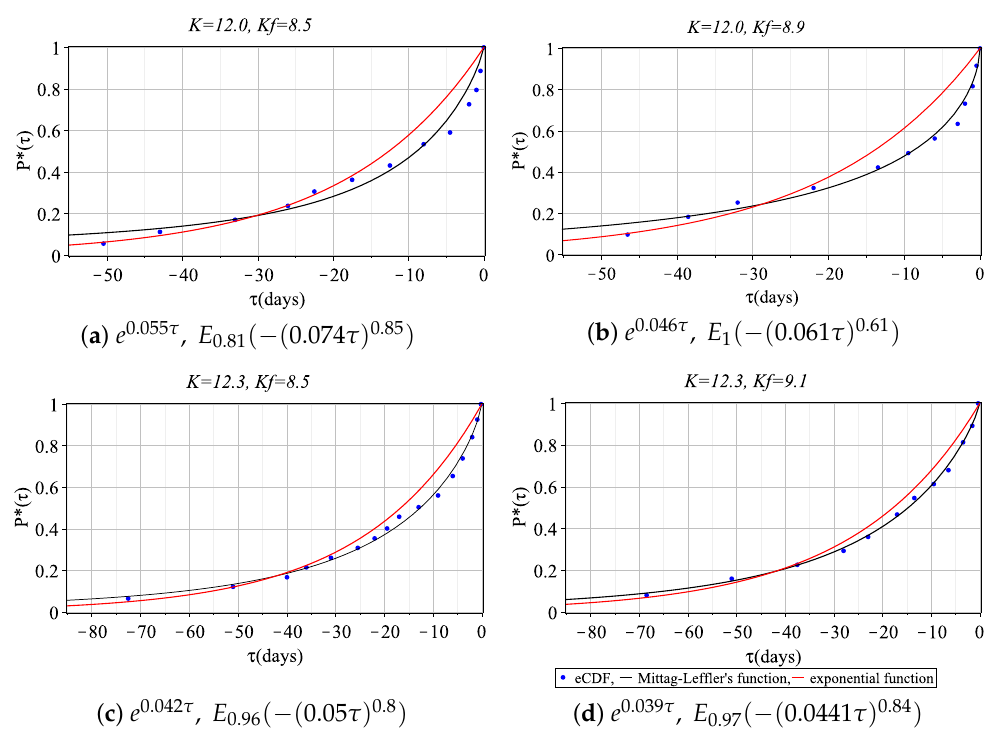
Figure 5. Approximation of the eCDF P ∗ ( τ ) of waiting time of foreshocks (class K f ) for the mainshock (class K ) by the Mittag–Leffler function E ν ( − ( ˜ µτ ) ˜ ν ) (4) and exponential function e µτ .